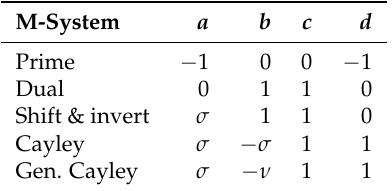
Table 2. Coefficients of special Möbius